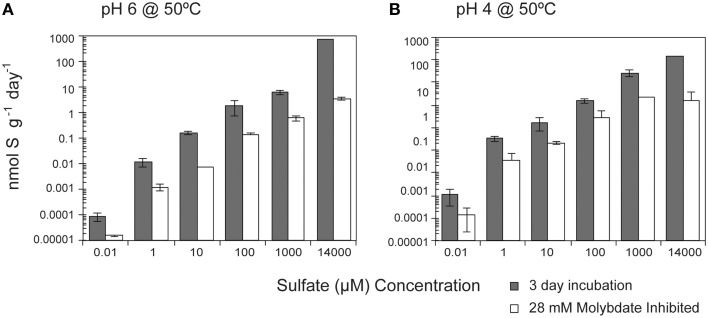
Effect of sulfate concentration on sulfate reduction rates. The crushed flange from the Grotto hydrothermal deposits were incubated for 3 days () at 50°C at (A) pH 6 or (B) pH 4. 28 mM molybdate amended samples were incubated under all conditions (□) as controls. Error bars represent 1 standard deviation.